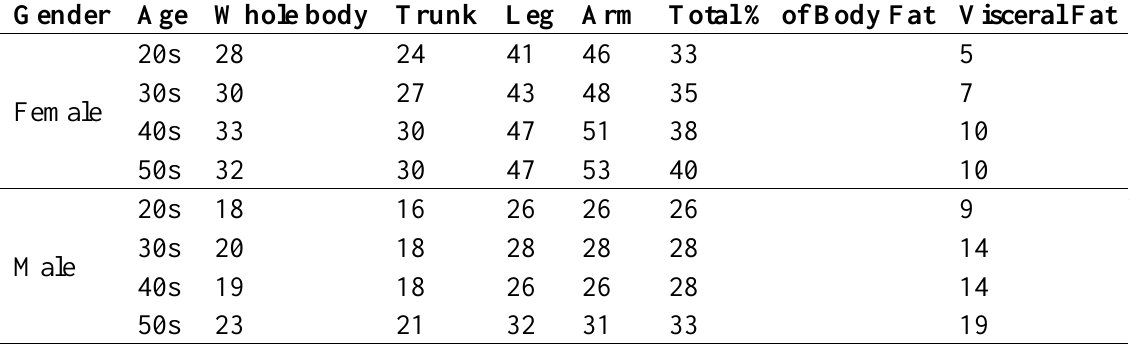
Table 4: Fat depot percentages in different age groups